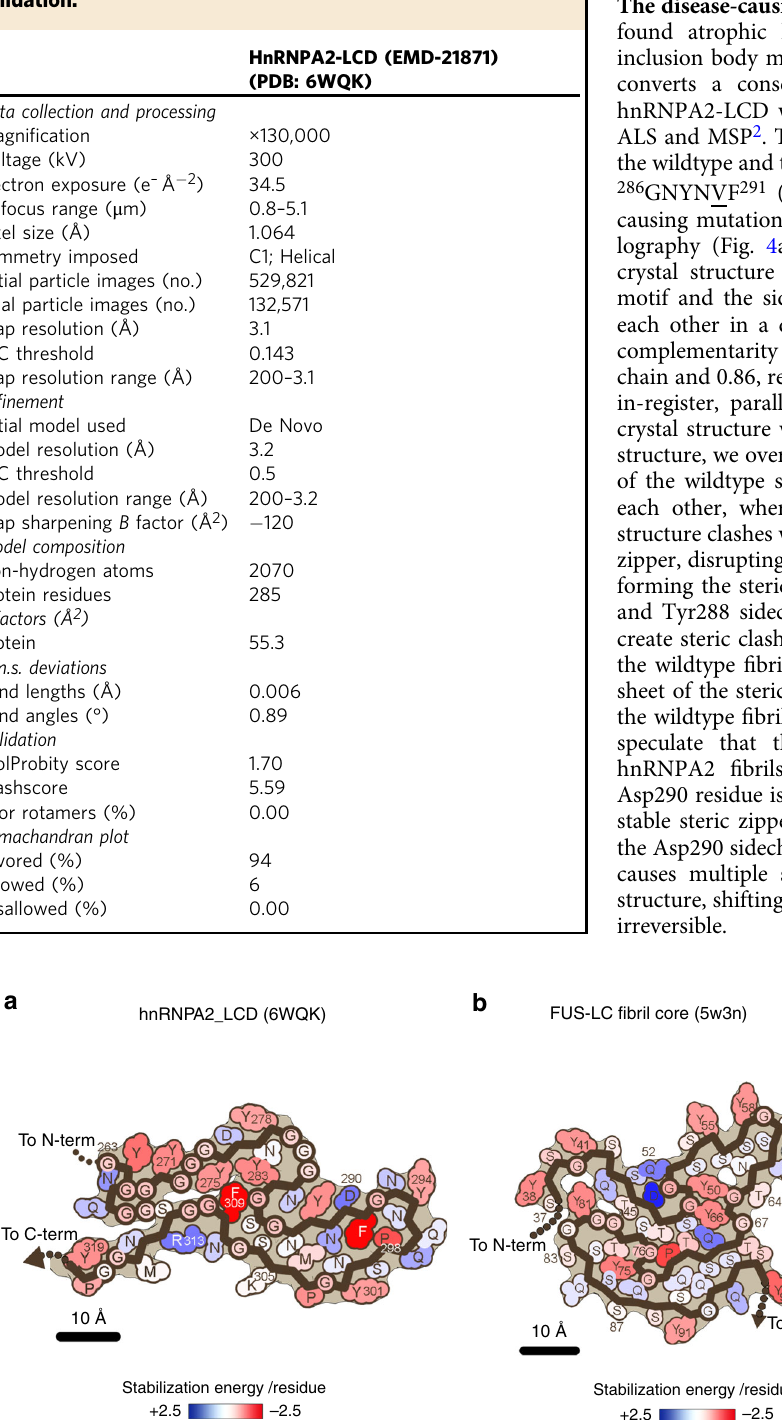
Table 1 Statistics of cryoEM data collection, re fi nement, and validation.